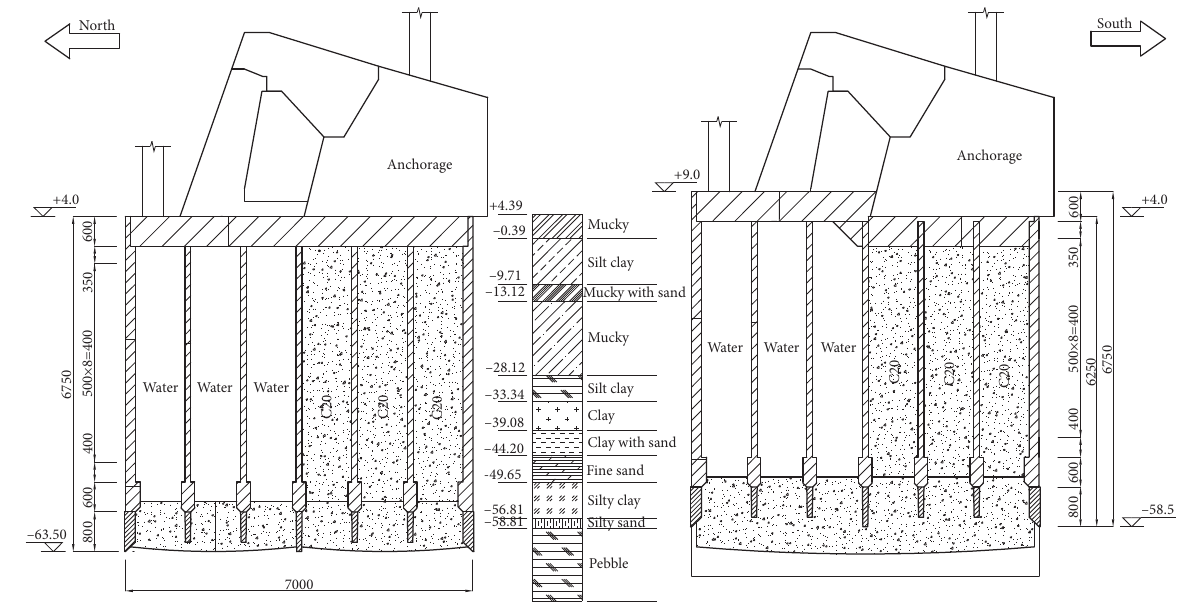
Figure 3: The vertical profile of caisson before and after design